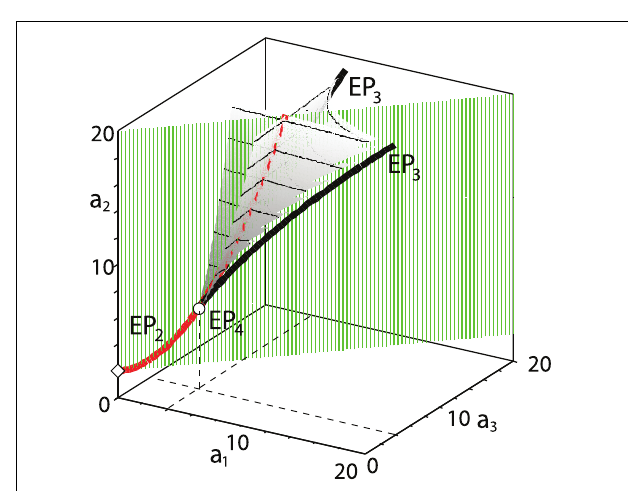
FIGURE 2 | The real parts of the roots of the polynomial (5) with the coefficients in the set (13) and (shown by the bold red curve) the abscissa (12).